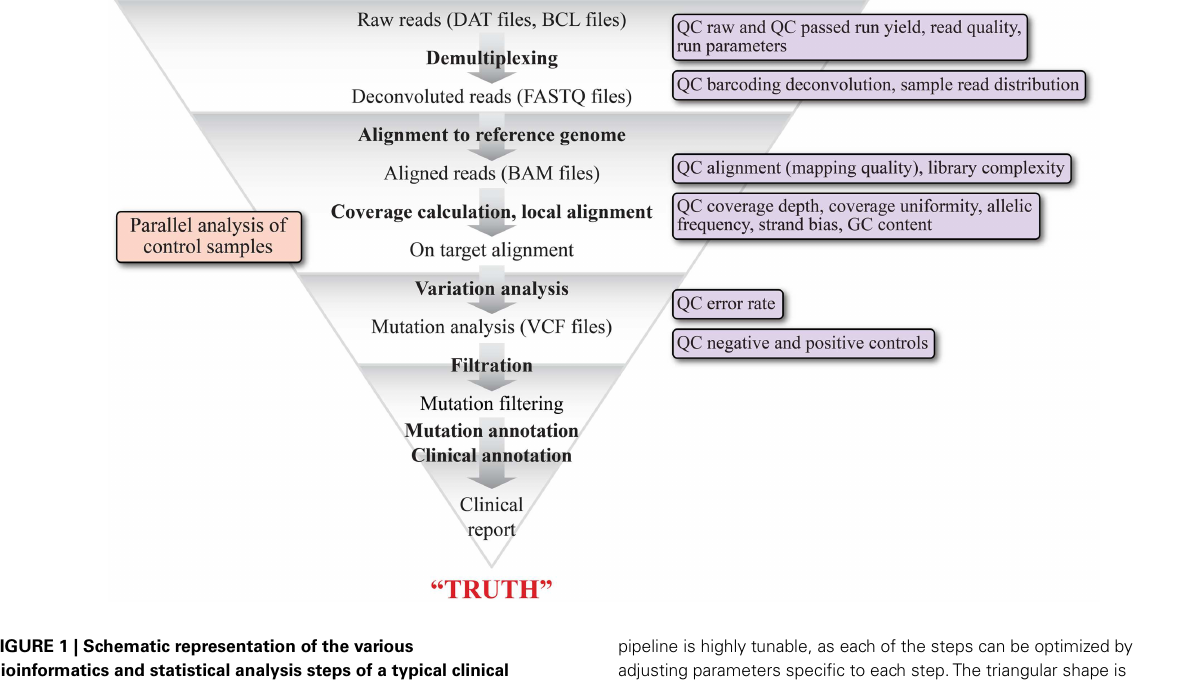
pipeline is highly tunable, as each of the steps can be optimized by adjusting parameters specific to each step.The triangular shape is intended to convey that each step acts as a filter to remove reads that do not represent variants.The key quality filters that can be applied are shown in the boxes to the